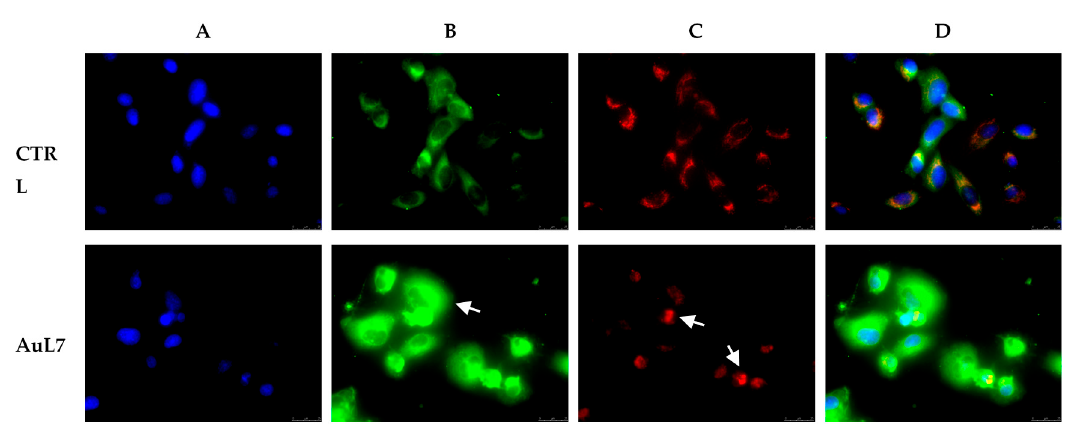
Figure 11. Mitochondria staining and cytochrome c translocation in MDA-MB-231 cells. In vehicle-treated cells, cytochrome c (panel B, CTRL) is localized within intact mitochondria (panel C, CTRL), as visible in panel D (CTRL) where the overlay channel is shown. Treatment with AuL7 at a concentration corresponding to its IC 50 value for 24 h induces cytochrome c release in the cytosol (panel B, AuL7 , white arrow) and loss of mitochondria integrity (panel C, AuL7 , white arrows). ( A ) nuclear stain with DAPI (excitation / emission wavelength 350 nm / 460 nm); ( B ) Alexa Fluor CF 488 (excitation / emission wavelength 490 nm / 515 nm); ( C ) MitoTracker Deep Red FM probe (excitation / emission wavelength 644 nm / 665 nm); ( D ) Overlay channels. Images were acquired at 63x magnification and representative fields are shown.